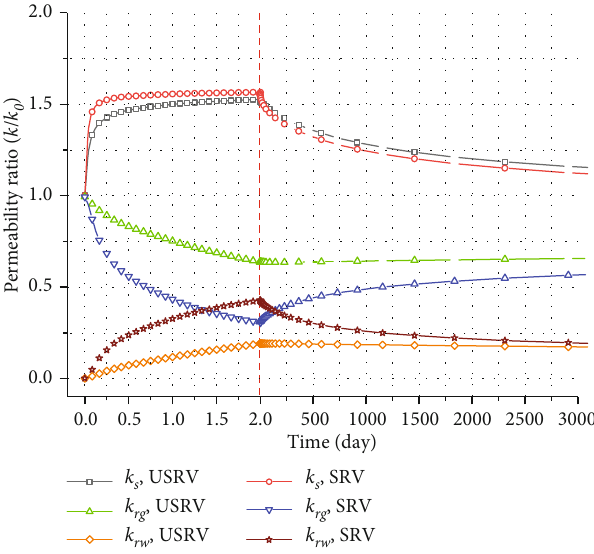
Figure 9: Gas/water relative permeability and intrinsic permeability of the SRV and USRV